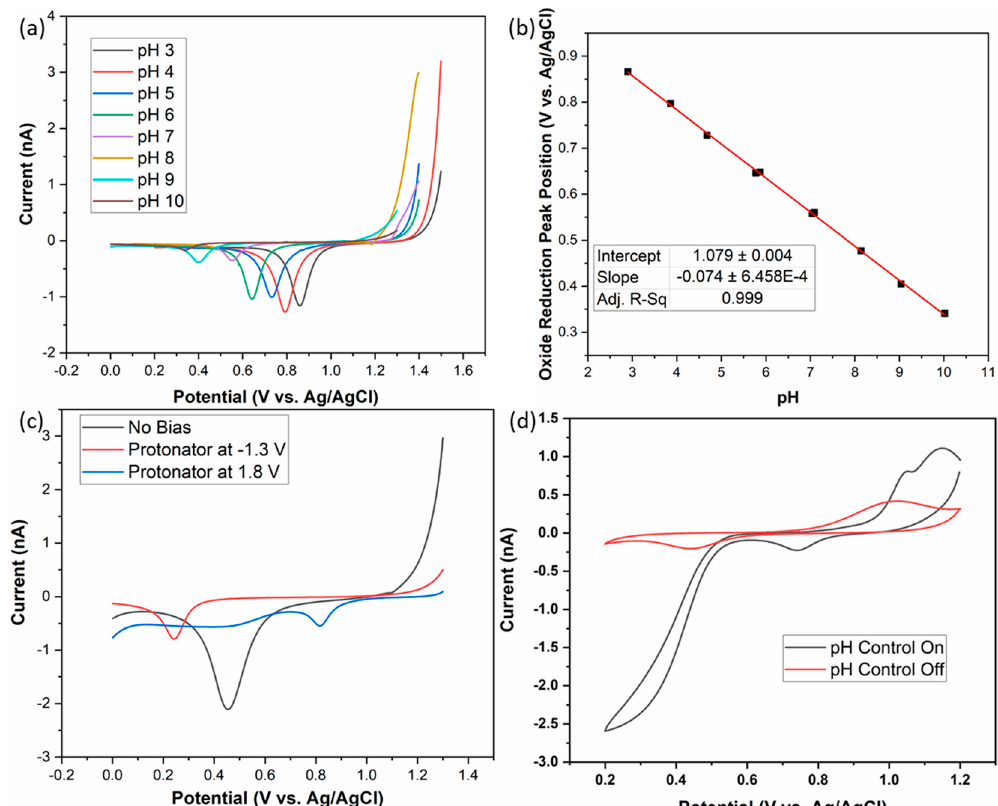
Figure 7. ( a ) LSVs in various pH buffers from 1.4 V to 0 V at 50 mV/s. ( b ) Calibration of the oxide reduction peak potential vs. pH. ( c ) LSVs of 1 mM Sodium Bicarbonate in DI water from 1.3 V to 0 V at 50 mV/s with various biases applied to the protonator electrode. ( d ) CVs, from 1.2 V to 0.2 V at 50 mV/s, in a 5 ppm sample of monochloramine with and without a potential bias of 1.75 V at the protonator electrode.